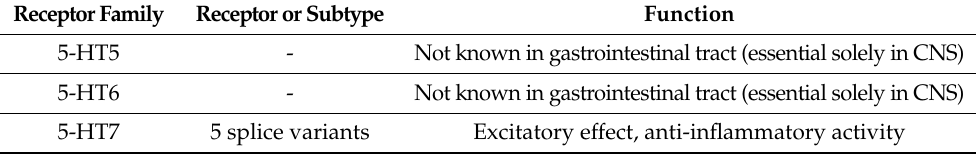
Table 1. Cont. Receptor Family Receptor or